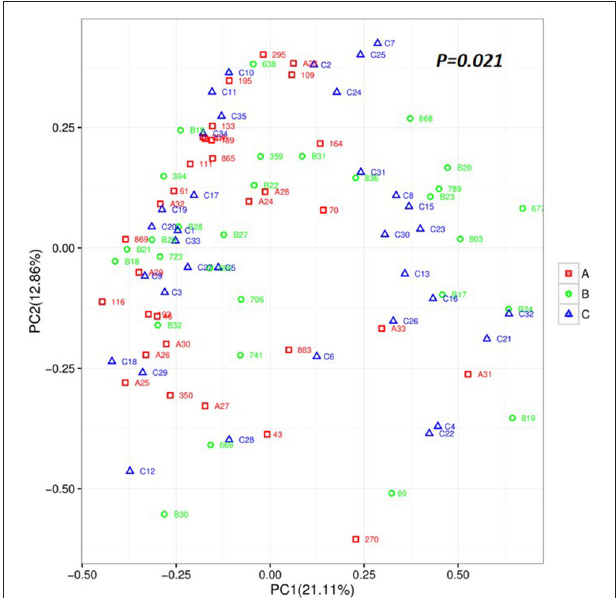
FIGURE 2 | Unweighted based on the distance matrix of UniFrac dissimilarity of the faecal microbial communities in the Acute set stage group, Remission stage group, and Healthy control groups. Respective R -values show the community variation between the compared groups, and significant P -values are indicated. Acute stage group (red), Remission stage group (green), and Healthy group (blue). PC, principal coordinate.